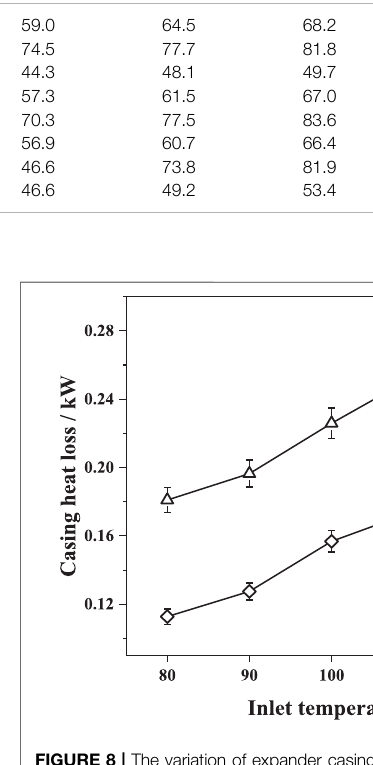
FIGURE 8 | The variation of expander casing heat loss with inlet